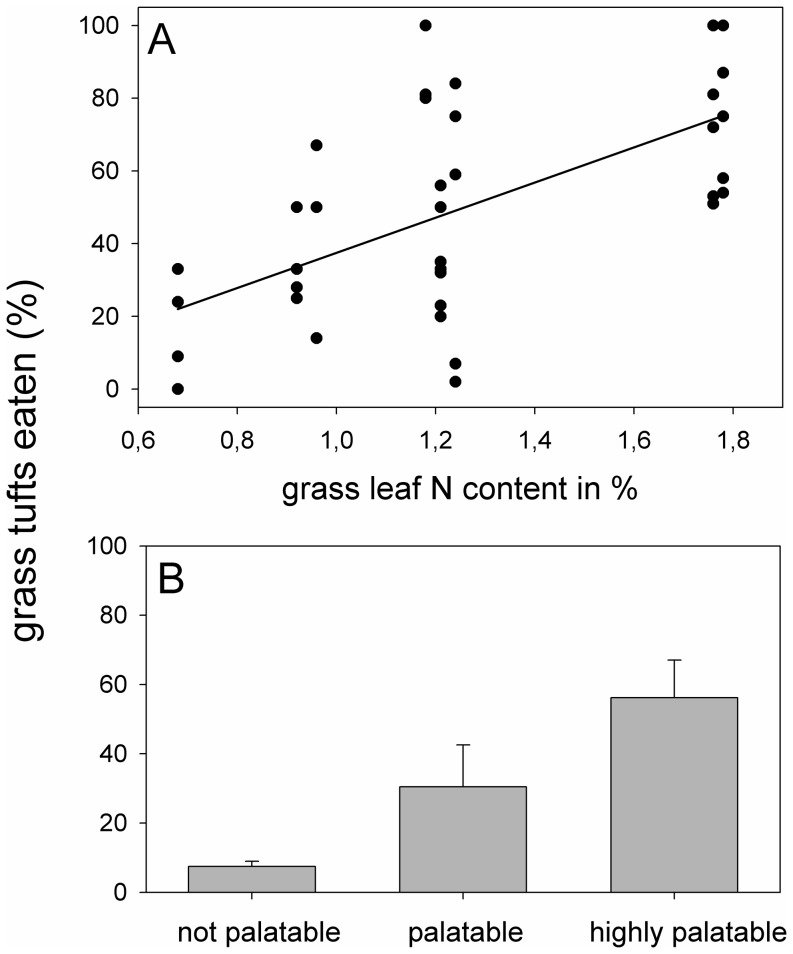
Percent of grazed grass tufts versus (A) grass leaf N content in % dry matter and versus (B) ranked palatability.